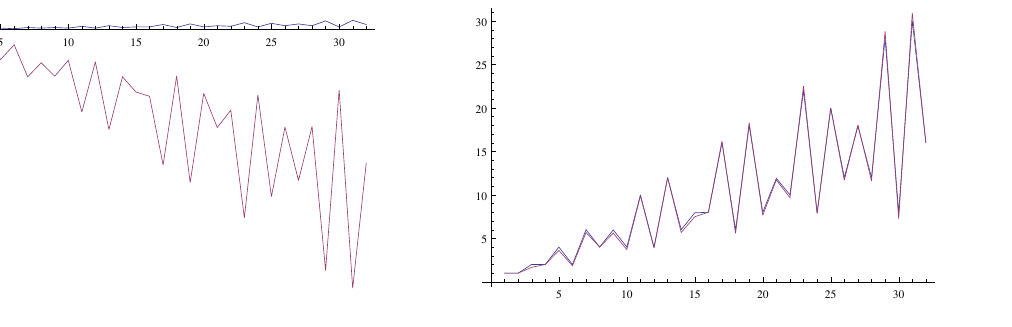
Figure 1 . Γ (1) plotted in units of log R , from cyc n n = 1 to 32. The blue line is for ℓ = 1 while the purple line is for ℓ = 2.